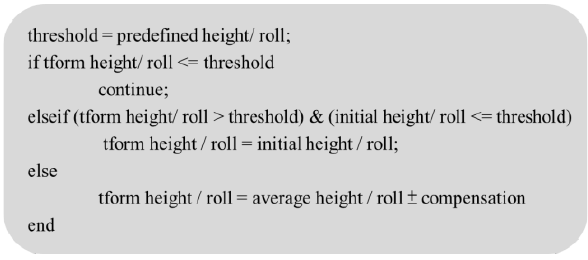
Figure 6 . FDI Scheme application for LiDAR